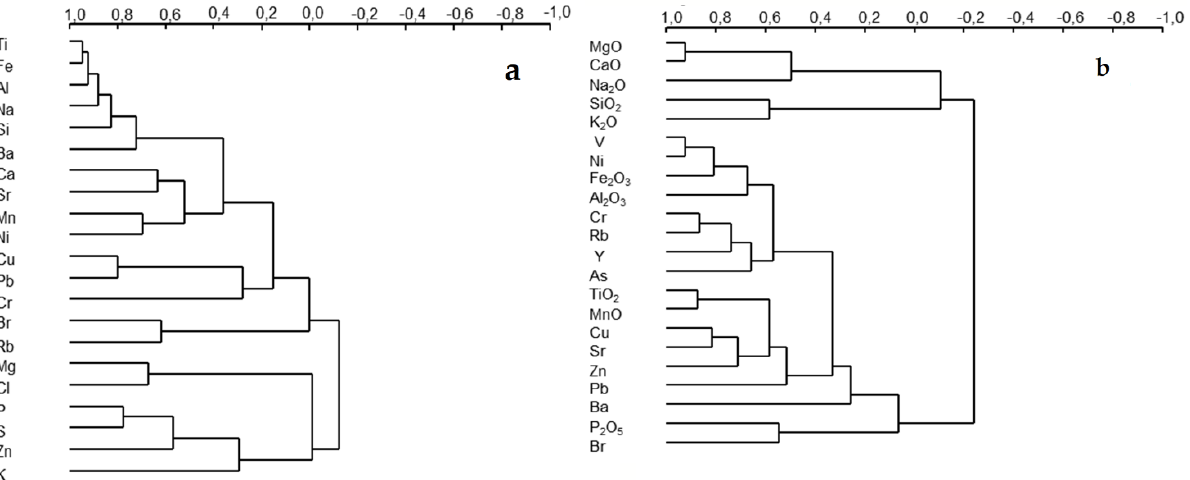
Figure 6. The results of cluster analysis of pine needles ( a ) and soils ( b ) chemical composition. The upper line is the scale of correlation coefficients between variables and groups of variables.